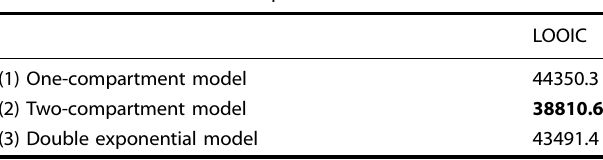
Table 1. Results of model comparison.